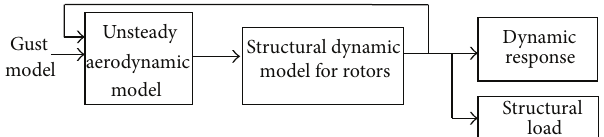
Figure 1: Aeroelastic model for rotor gust analysis.